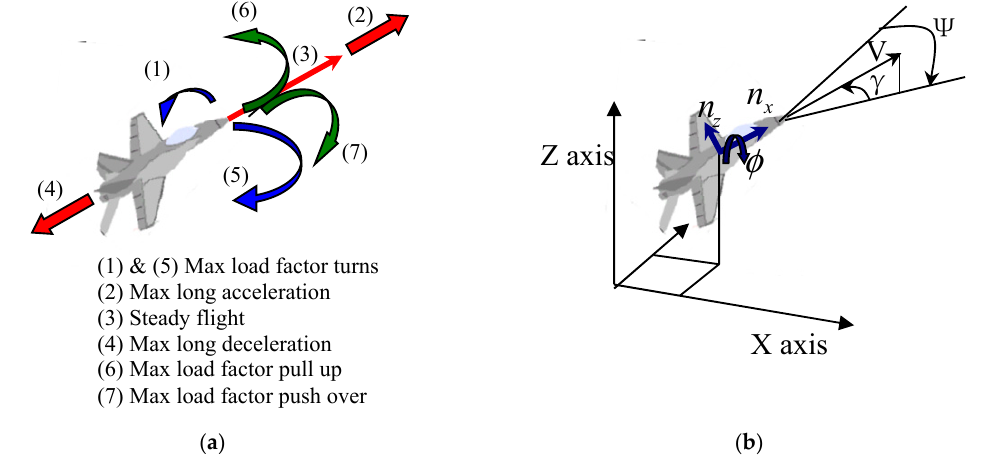
Figure 2. ( a ) Fighter flight strategies; ( b ) representation of the fighter in the local reference frame XYZ.